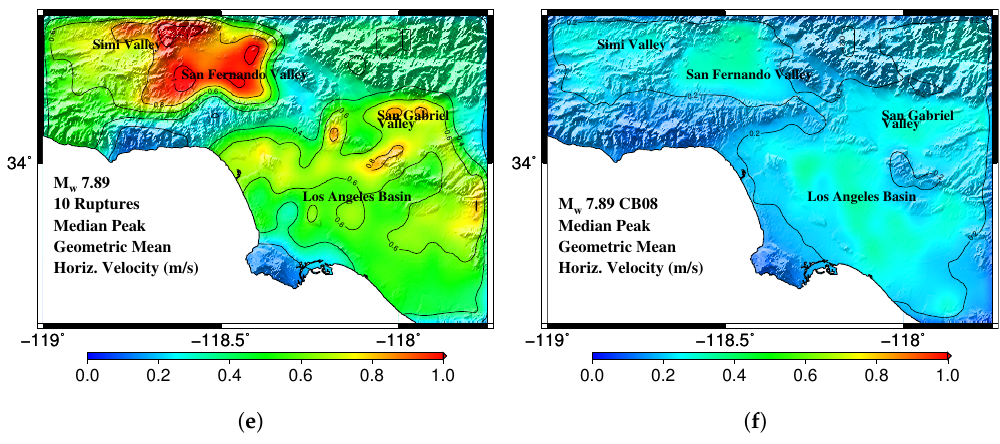
Figure 6. Comparison of maps of median peak geometric mean horizontal velocities (m/s) in the Los Angeles basin from simulations of ten scenario San Andreas fault earthquakes at three magnitude levels to predictions using the CB-08 NGA relations. ( a , b ) Magnitude M w 7.28, ( c , d ) Magnitude M w 7.59, and ( e , f ) Magnitude M w 7.89.